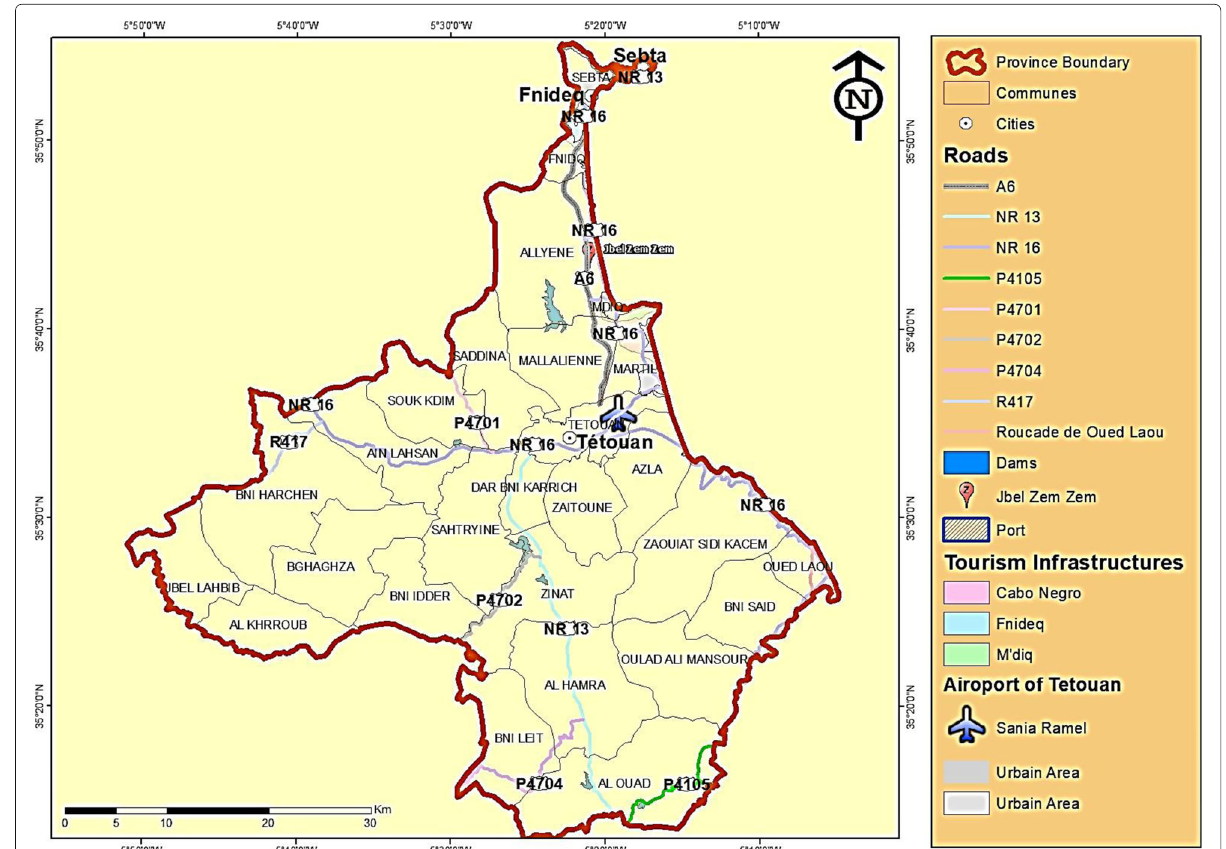
Fig. 8 Map of dams, tourist infrastructure and roads in Tétouan